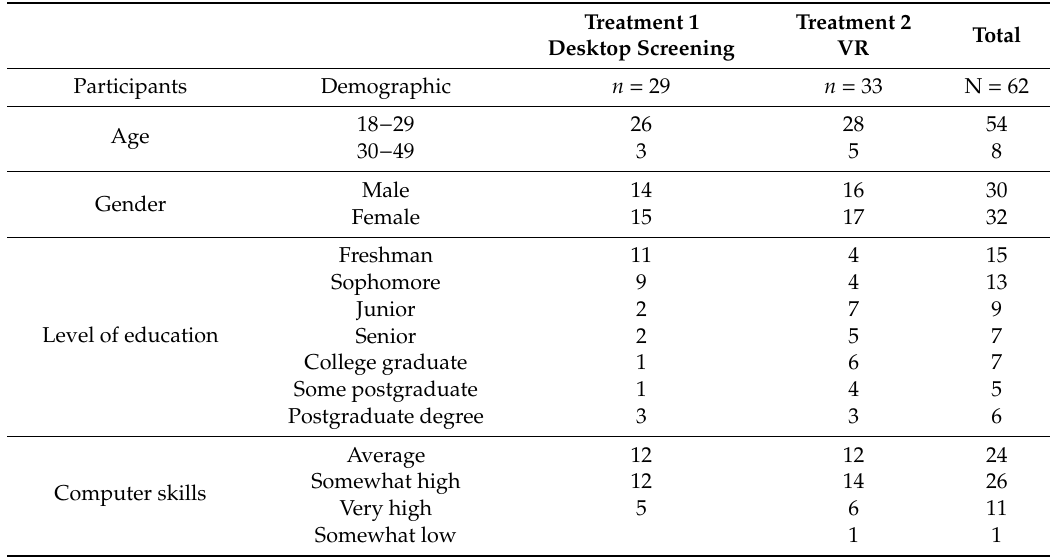
Table 1. Participants Demographic Frequencies on Gender and Level of